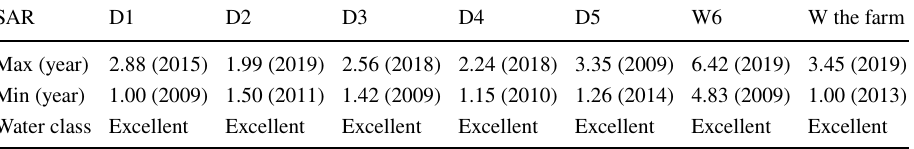
classes of groundwater, the Mougheul